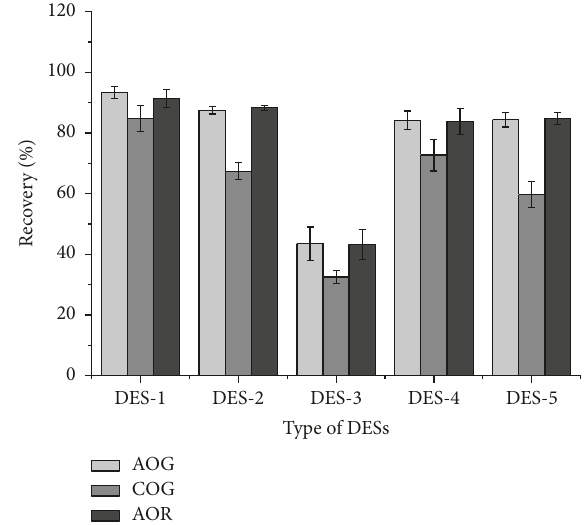
Figure 1: Effect of different type of DES on the recoveries of COG, AOG, and AOR. Molar ratio of ChCl to HBD: 1/3, sample/liquid: 0.1 g/mL, temperature: 30.0 ∘ C, time: 20 min, and ultrasonic power: 75